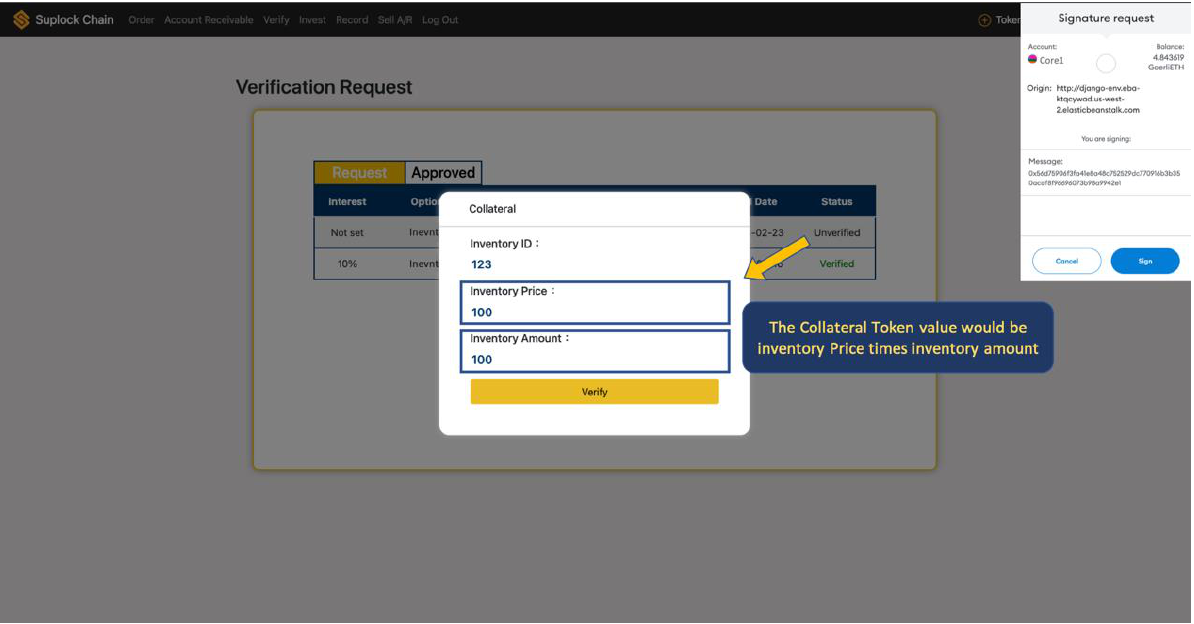
Figure A15. Module for company locking in collateral. Core1 requests funding by collateral inven- tories on our website.